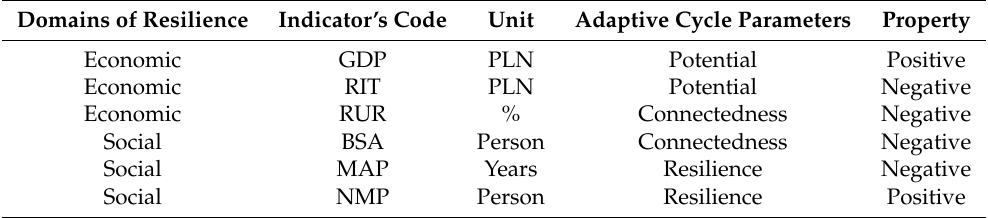
Table 1. Evaluation index system of socio–economic resilience in Poland’s lignite